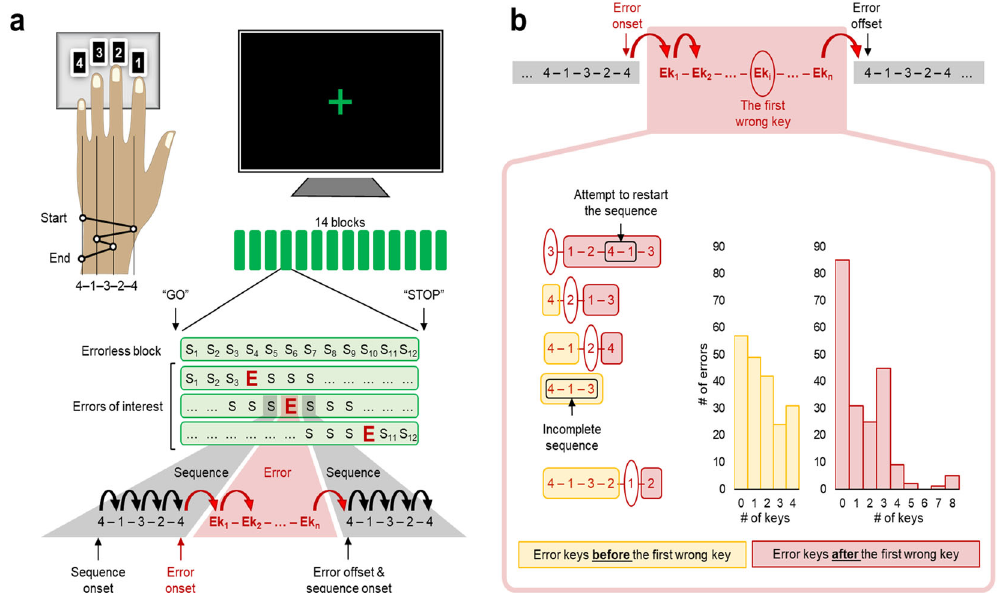
Fig. 1 Study design and errors of interest. a Participants were scanned while tapping a fi ve-element sequence (S: 4 – 1 – 3 – 2 – 4) on a keypad using their left hand. The session consisted of 14 successive performance blocks with 60 keypresses, equivalent to 12 repetitions of the correctly performed and completed sequence (i.e., correct trials; S 1 , S 2 , … , S 12 ), each block being separated by 15-s periods of rest. During performance blocks, participants were asked to look at a fi xation cross and to tap the sequence repeatedly as fast and accurately as possible. In case of errors, they were instructed to continue with the task as smoothly as possible from the beginning of the sequence. A change in the color of the fi xation cross from red to green and from green to red indicated the beginning (GO) and the end (STOP) of each performance block, respectively. Only isolated errors preceded and followed by at least three correct trials in a row were analyzed; the last error within the block followed by at least two correct trials in a row was also considered. b All wrong keypresses that violated the predetermined order (i.e., sequence) or incomplete sequences with missing keys, between two correct trials, were considered as a single error. Thus, the fi rst wrong keypress that violated the sequential order (marked with red oval) can be the fi rst, second, third, fourth, or fi fth error key. S — correct trial, i.e., one correctly performed and completed sequence, E — erroneous trial, i.e., an error, Ek 1 … Ek n — keys within the error, Ek i — the fi rst wrong key within the error, black rounded arrows — transitions within the sequence, red rounded arrows — error